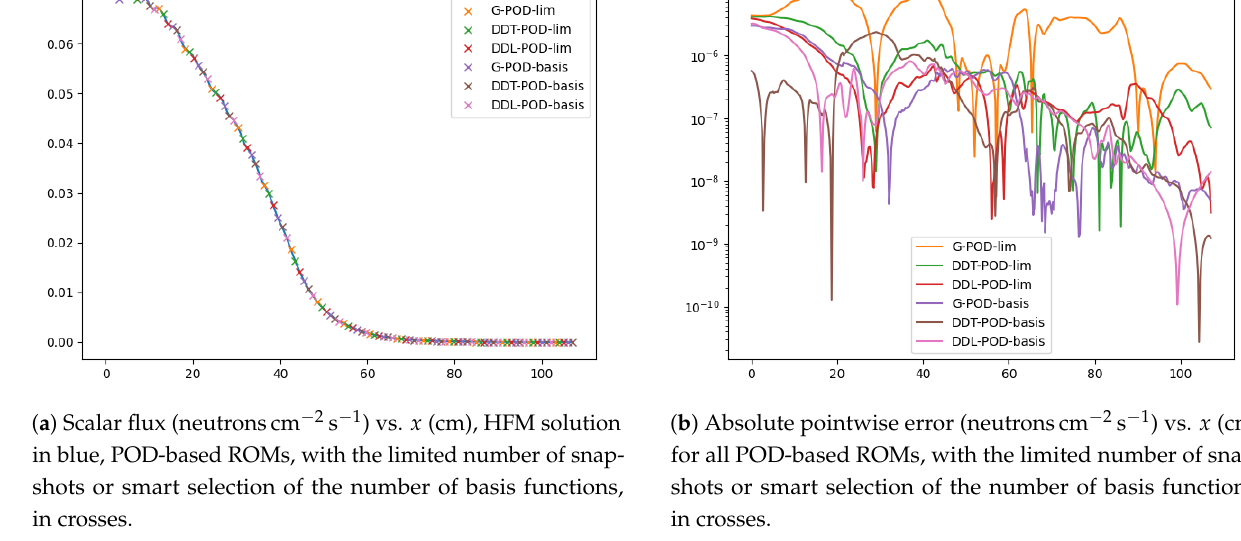
Figure 12. Scalar flux for Energy Group 1 for the HFM (blue) and POD-based ROMs, with limited number of snapshots or smart selection of number of basis functions, in crosses, and the pointwise error between them with parameters R 1 = 2, R 2 = 2, R 3 = 1, R 4 = 1, R 5 =